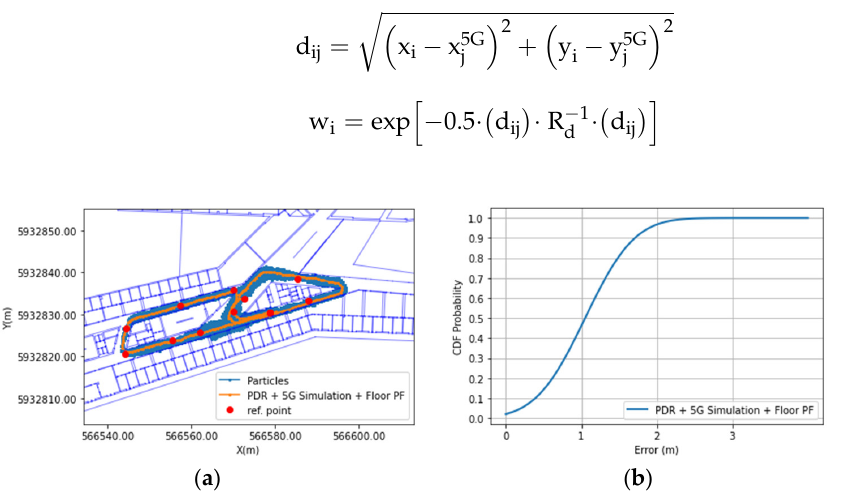
Figure 11. PDR PF with map and 5G simulation: ( a ) The trajectory; and ( b ) Error vs. CDF probability of the mentioned